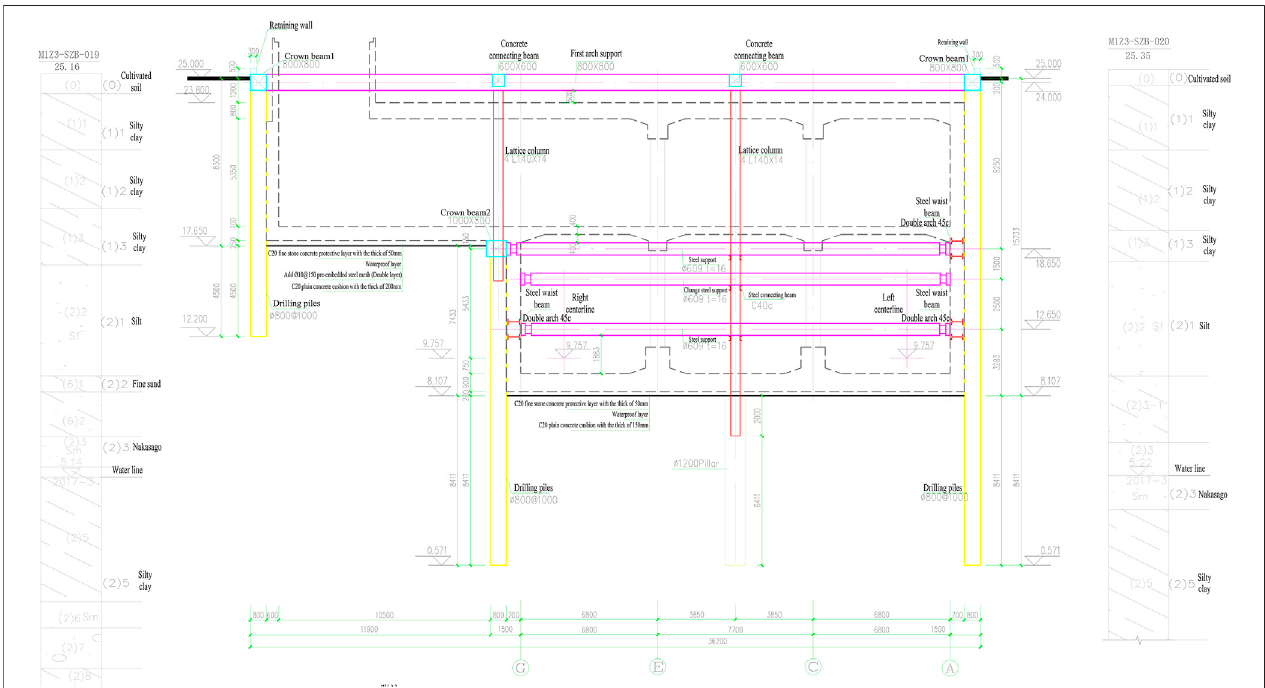
FIGURE 1 | The borehole histogram and support design of the standard